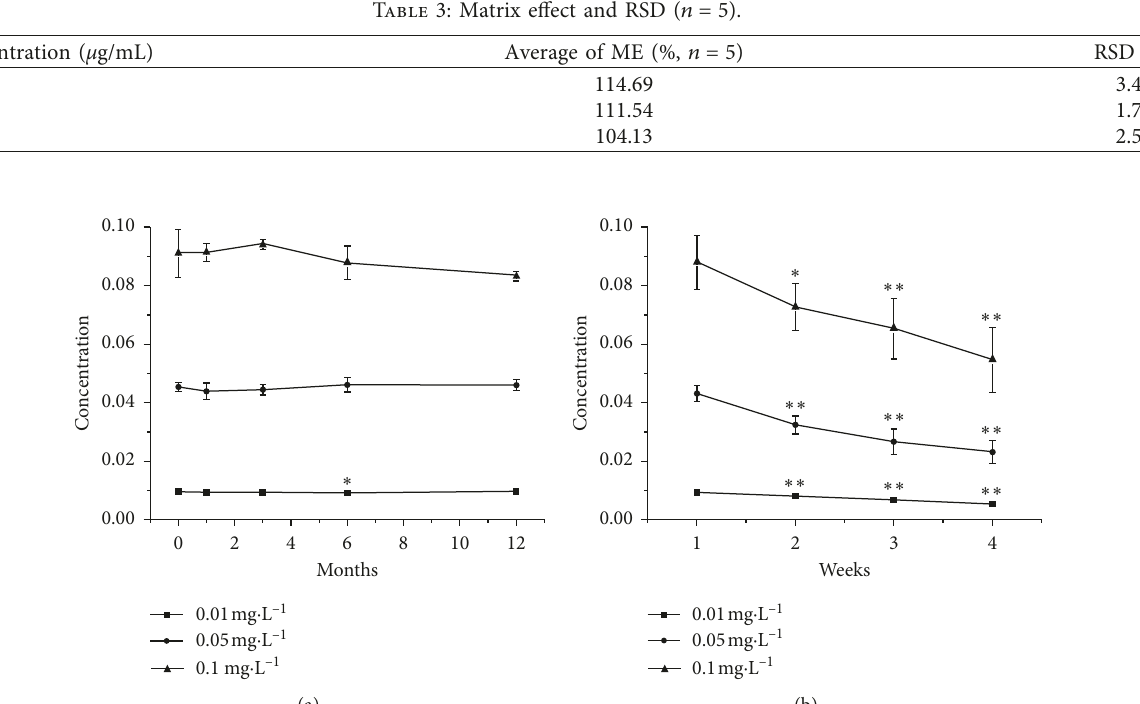
Table 3: Matrix effect and RSD ( n